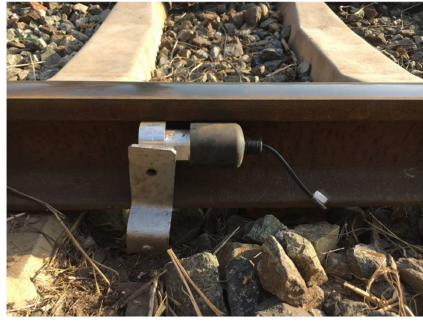
Figure 15. Installation of ultrasonic transducer at rails.